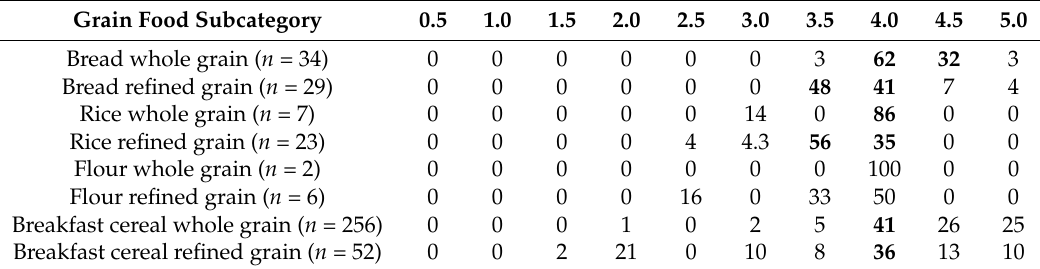
Table 3. Distribution of HSR scores in each subcategory